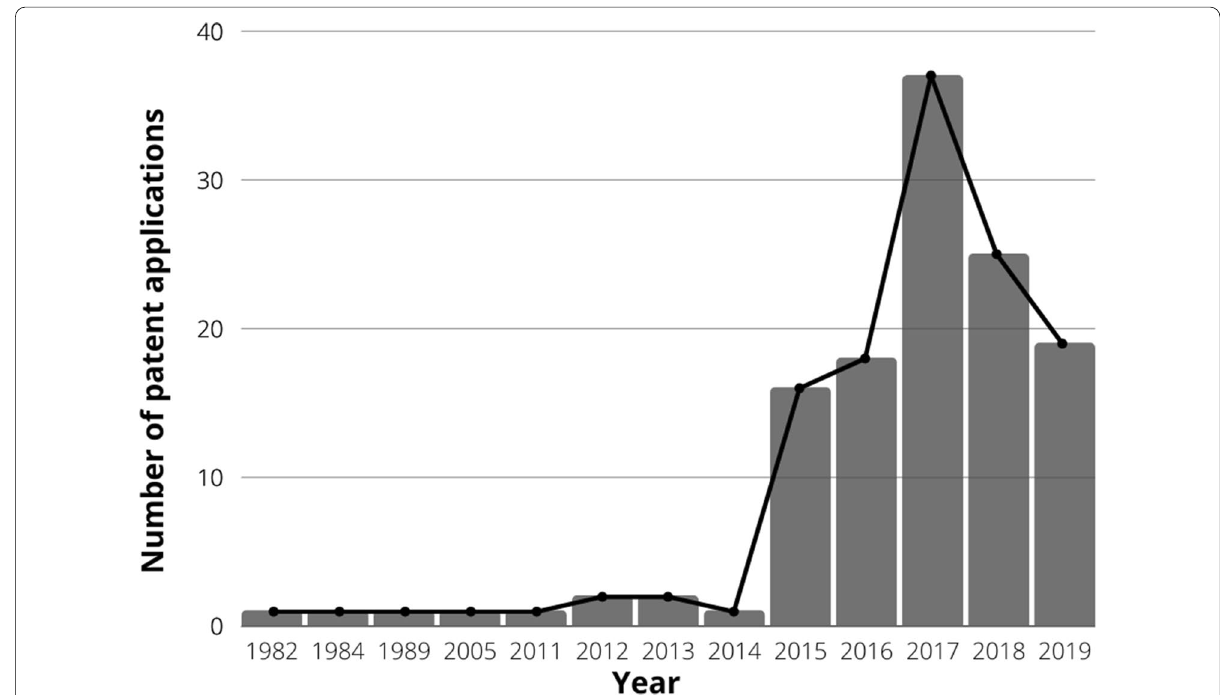
Fig. 2 Application activity timeline of patents related to microalgae in agriculture per year